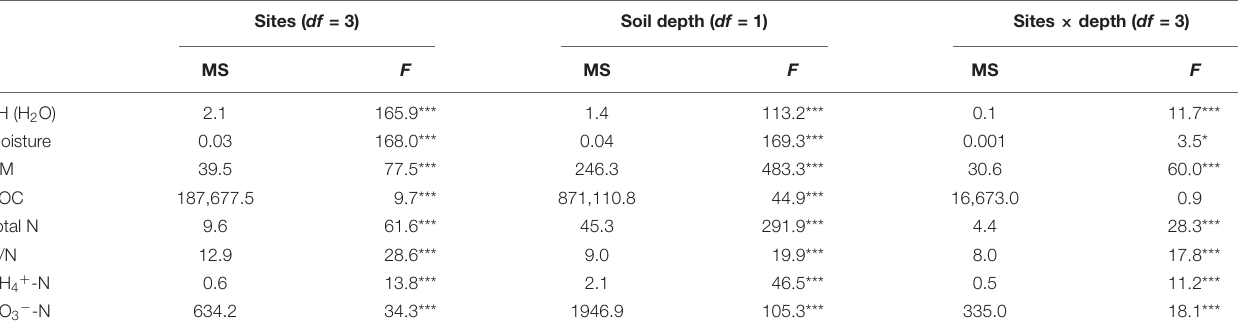
TABLE 4 | Overall effects of the sampling site and soil depth on the soil physicochemical characteristics analyzed by two-way